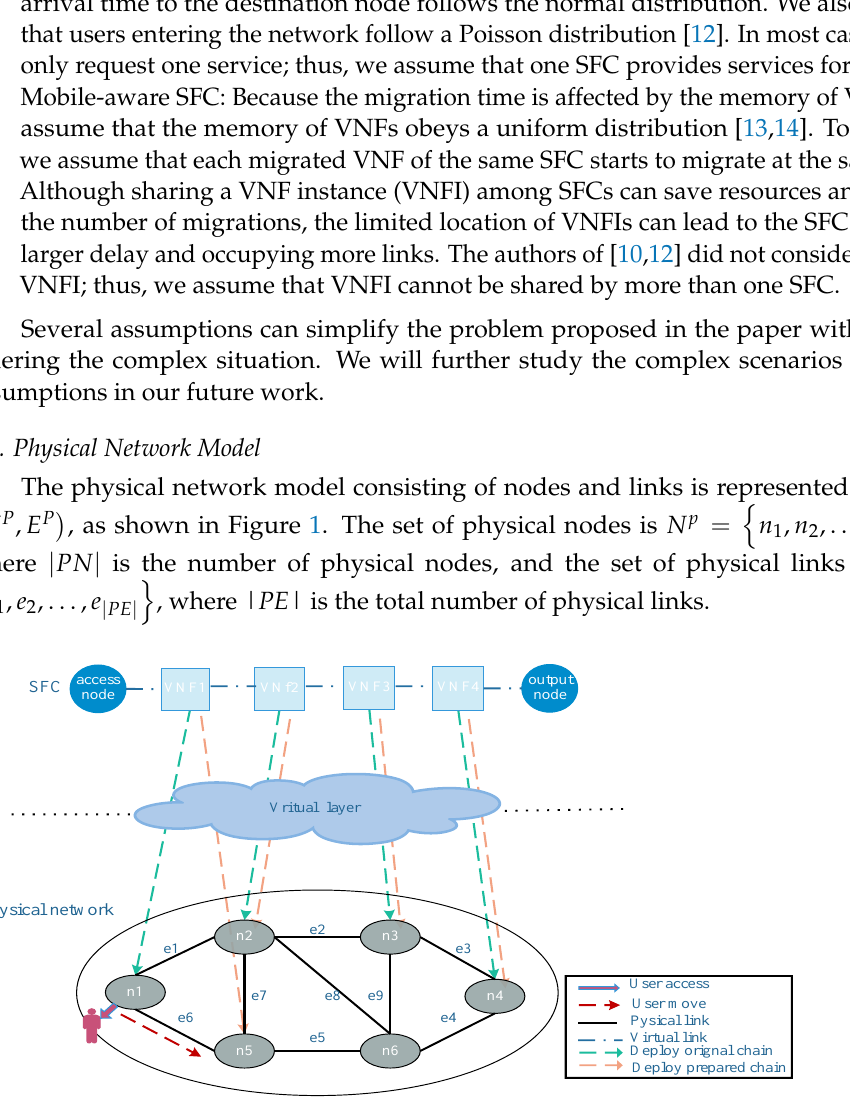
Figure 1. System Figure 1. System model.